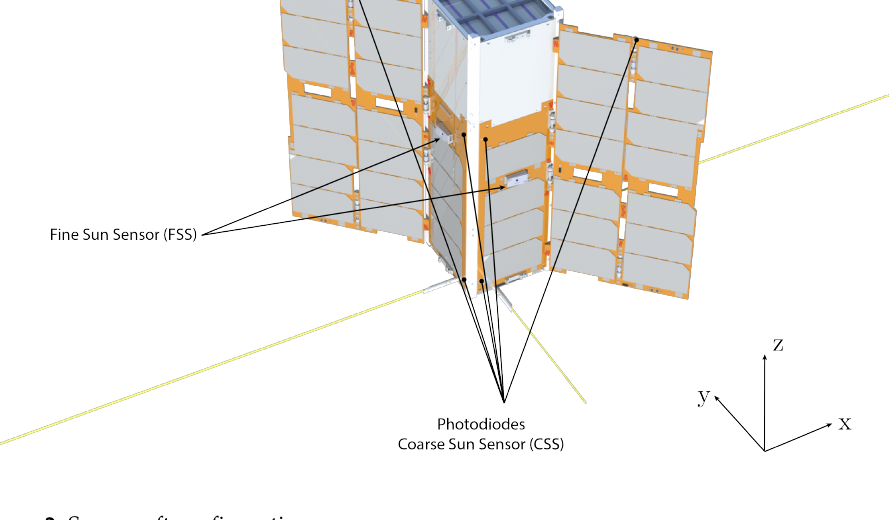
Figure 2. Spacecraft configuration.